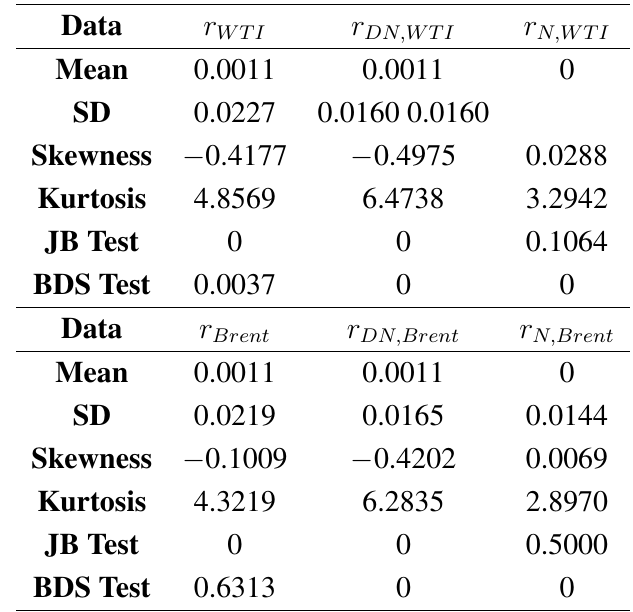
Table 1. Descriptive statistics and statistical